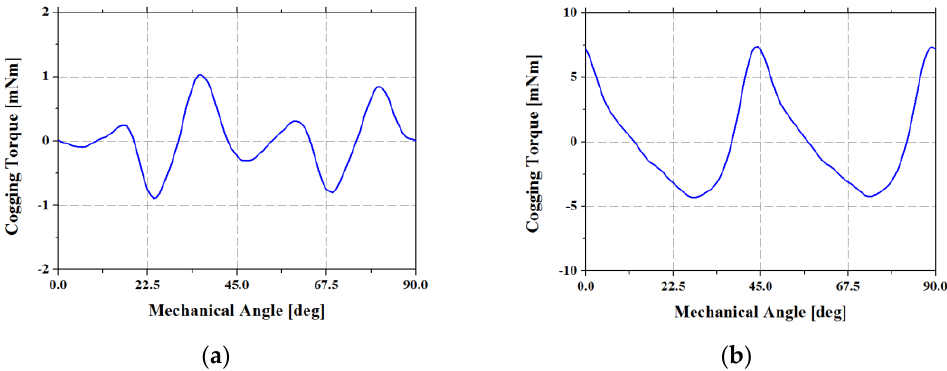
Figure 9. Comparison of cogging torque between the base and proposed model: ( a ) base model; ( b ) proposed model.